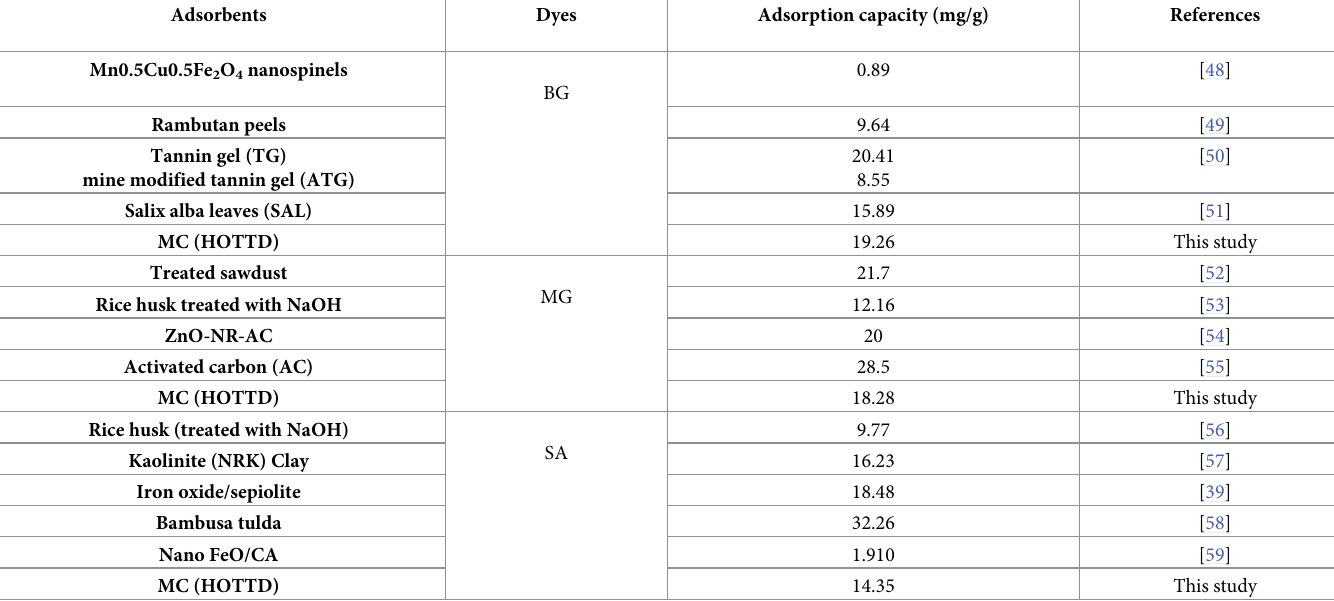
Table 4. Comparison of BG, MG, and SA adsorbent in different adsorbent materials.